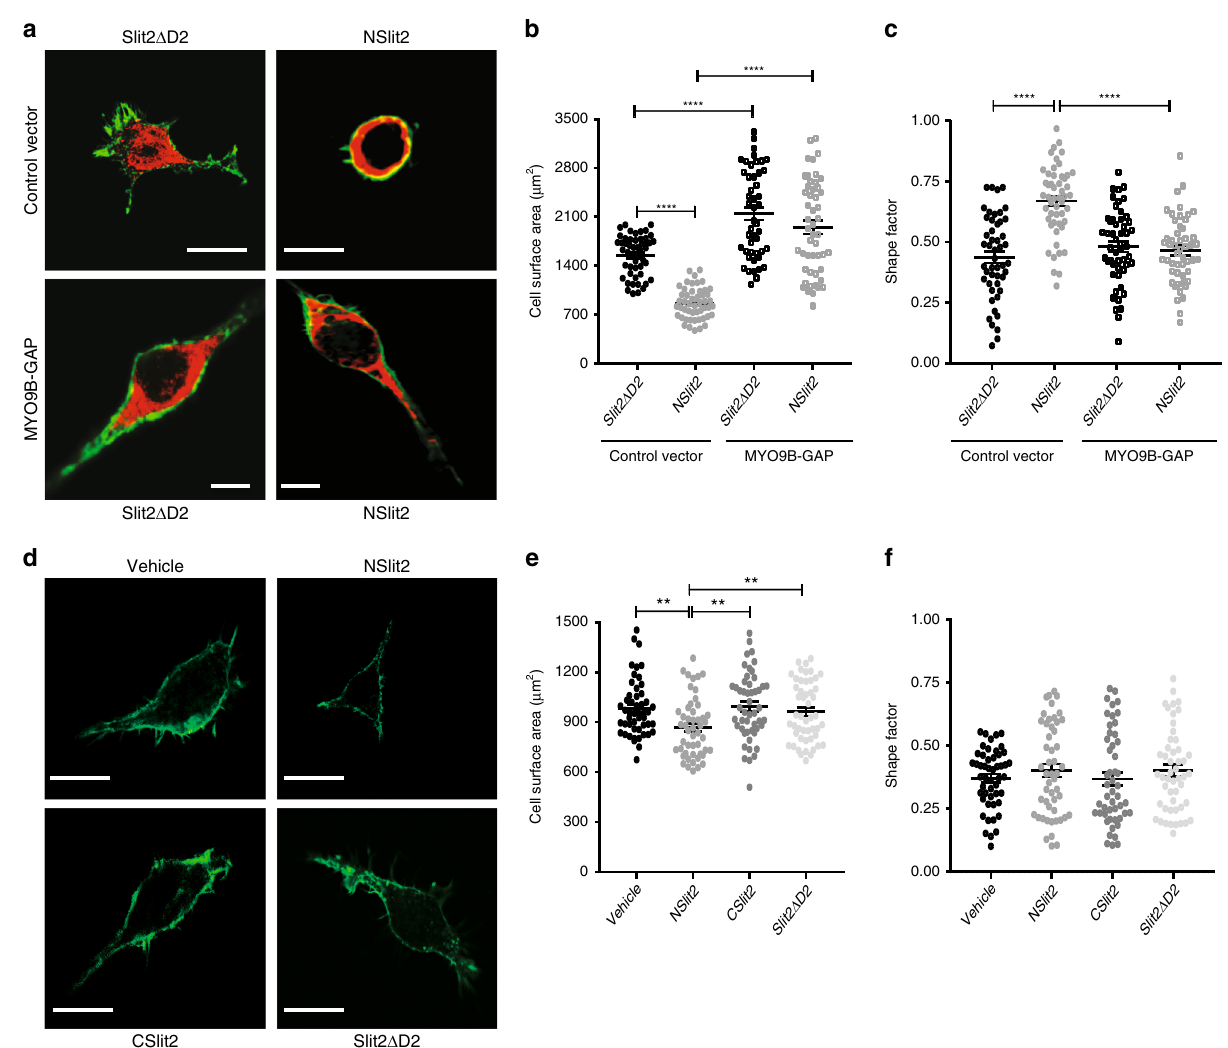
Fig. 3 NSlit2-induced RhoA activation in macrophages is mediated by inactivation of MYO9B. a A cDNA plasmid encoding c-myc-tagged MYO9B-GAP (Supplementary Fig. 3e) was expressed in RAW264.7 cells. After 48 h, cells were incubated with NSlit2 or Slit2 Δ D2 for 15 min at 37 °C and allowed to spread on poly- D -lysine-coated coverslips for 1 h. Cells were fi xed, permeabilized, and incubated with AF-488-conjugated phalloidin (green) and an antibody directed to c-Myc (red). Scale bar, 25 μ m. ( b , c , e , f ) Data are presented as mean ± SEM. Comparisons between the groups were made by ANOVA, followed by post hoc Tukey ’ s multiple comparison test. n = 50 cells per treatment group per experiment over three independent experiments. b Experiments were performed as in ( a ). Cell surface area was measured as in Fig. 1d. **** p < 0.0001, for the indicated comparisons and p = 0.3388, MYO9B-GAP NSlit2 vs MYO9B-GAP Slit2 Δ D2. c Shape factor for cells in ( a ) was measured as in Fig. 1e. **** p < 0.0001, for the indicated comparisons and p = 0.6416, MYO9B-GAP NSlit2 vs MYO9B-GAP Slit2 Δ D2. d Experiments were performed as Fig. 1c but cells were fi rst incubated with the myosin II inhibitor, blebbistatin, for 30 min. Scale bar, 25 μ m. e Cell surface area was measured for ( d ) as in Fig. 1d. ** p = 0.0032, 0.0043, and 0.0022 for NSlit2 vs vehicle, CSlit2, and Slit2 Δ D2, respectively. f Shape factor for cells in ( d ) was measured as in Fig. 1e. p = 0.7848, 0.5049, and 0.6879 for NSlit2 vs vehicle, CSlit2, and Slit2 Δ D2, respectively. Source data for ( b , c , e , f ) are provided as a Source Data fi